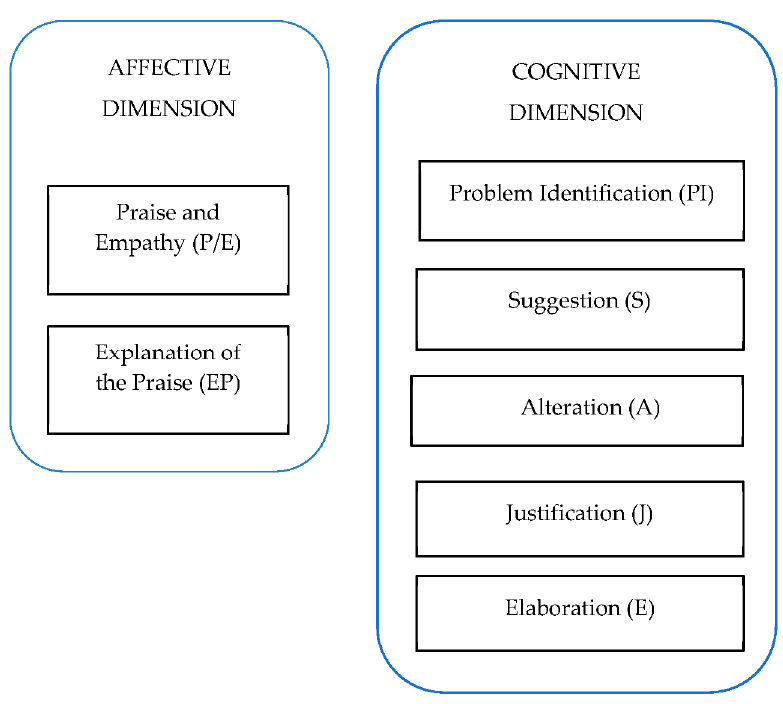
Figure 4. Adjusted feedback taxonomy used to classify students’ comments (Lu and Law 2012; Min 2005).